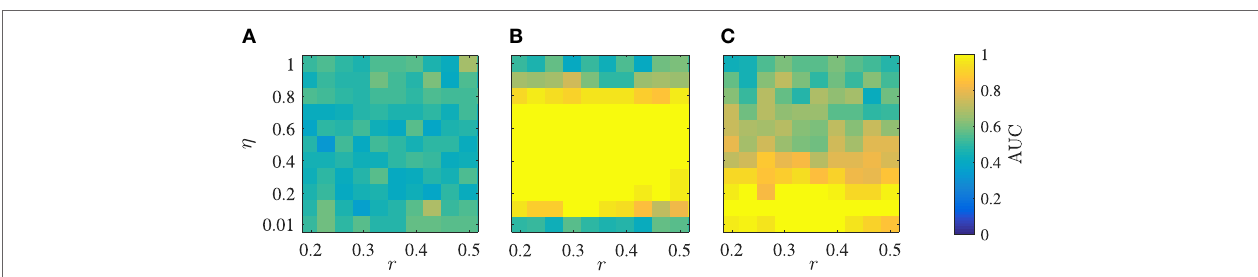
FIGURE 4 | Performance of the three classification methods in detecting the single leader measured by their AUC as a function of the radius of interaction r and the noise intensity (cid:17) for cross-correlation (A) , transfer entropy (B) , and event synchronization (C) , with N = 5 and v = 0.01.